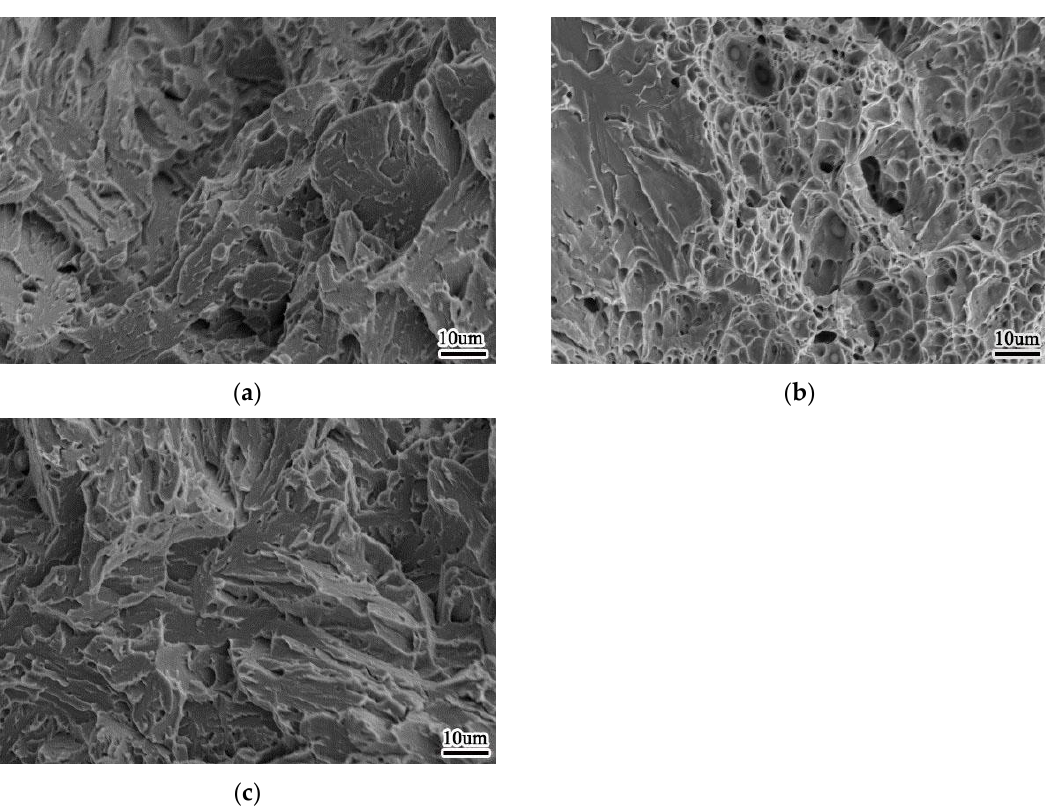
Figure 14. Morphology of impact fracture of weld metal at –60 °C ( a ) 0%Zr ( b ) 0.0061%Zr ( c ) 0.0135%Zr.